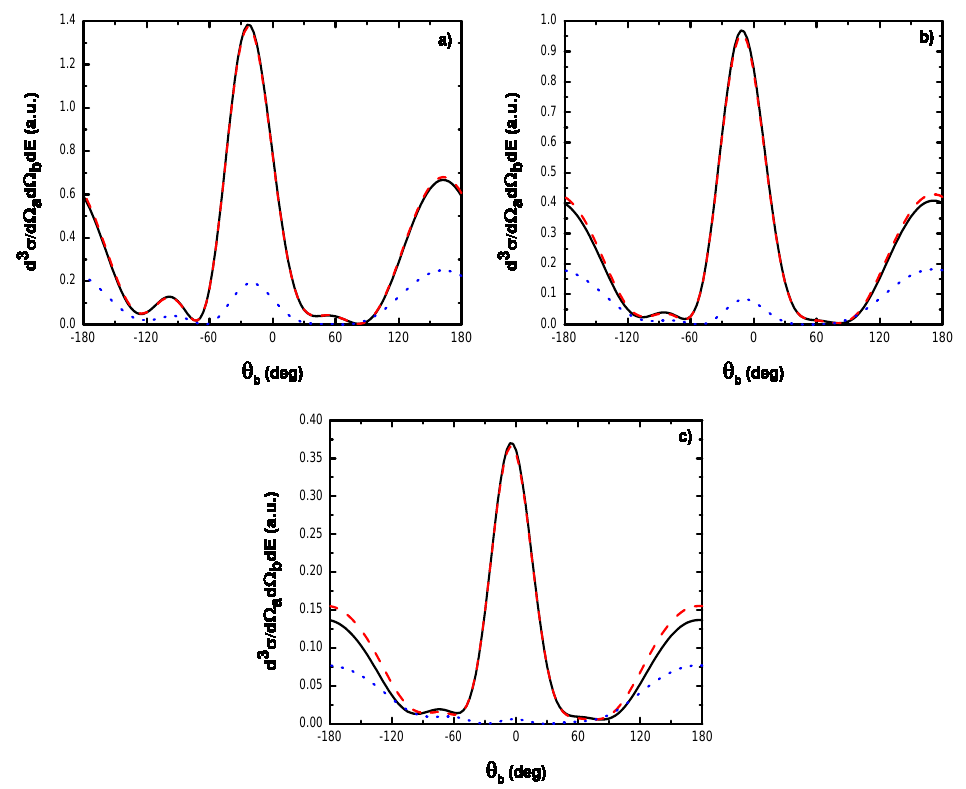
Figure 5. The same as in Figure 4, but with the absorption of one photon ( (cid:96) = 1 ) .